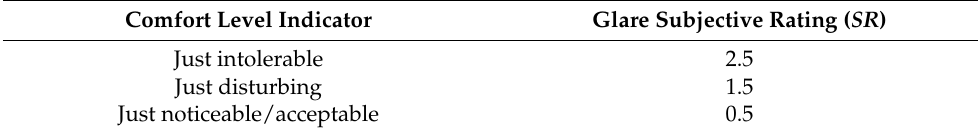
Table 1. Criterion scale of discomfort glare subjective rating (SR) [63].